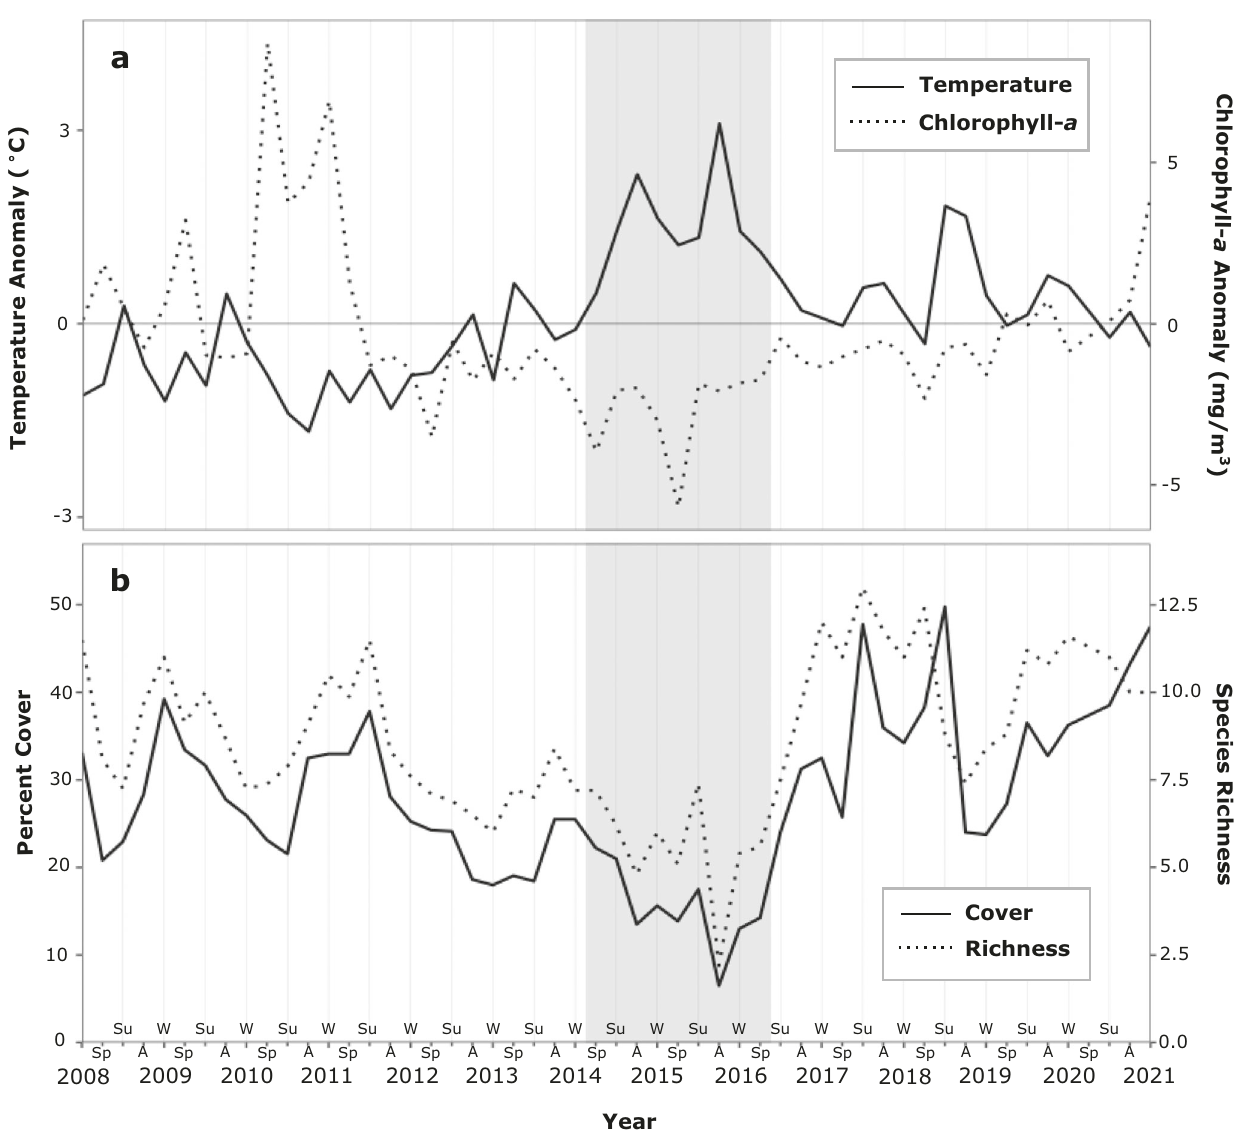
Fig. 1 Average seasonal bottom temperature anomaly, chlorophyll- a concentration anomaly, and percent cover and species richness of sessile invertebrates across fi ve sites. The Blob, an anomalous warming period from spring of 2014 to winter of 2016, is highlighted in gray, coincident with ( a ) positive temperature anomalies (°C; solid line), negative chlorophyll- a anomalies (mg/m 3 ; dashed line), and declines in ( b ) invertebrate cover (solid line) and species richness (number of unique species/taxa/80 contact points; dashed line). Seasons are denoted by Sp (Spring), Su (Summer), A (Autumn) and W